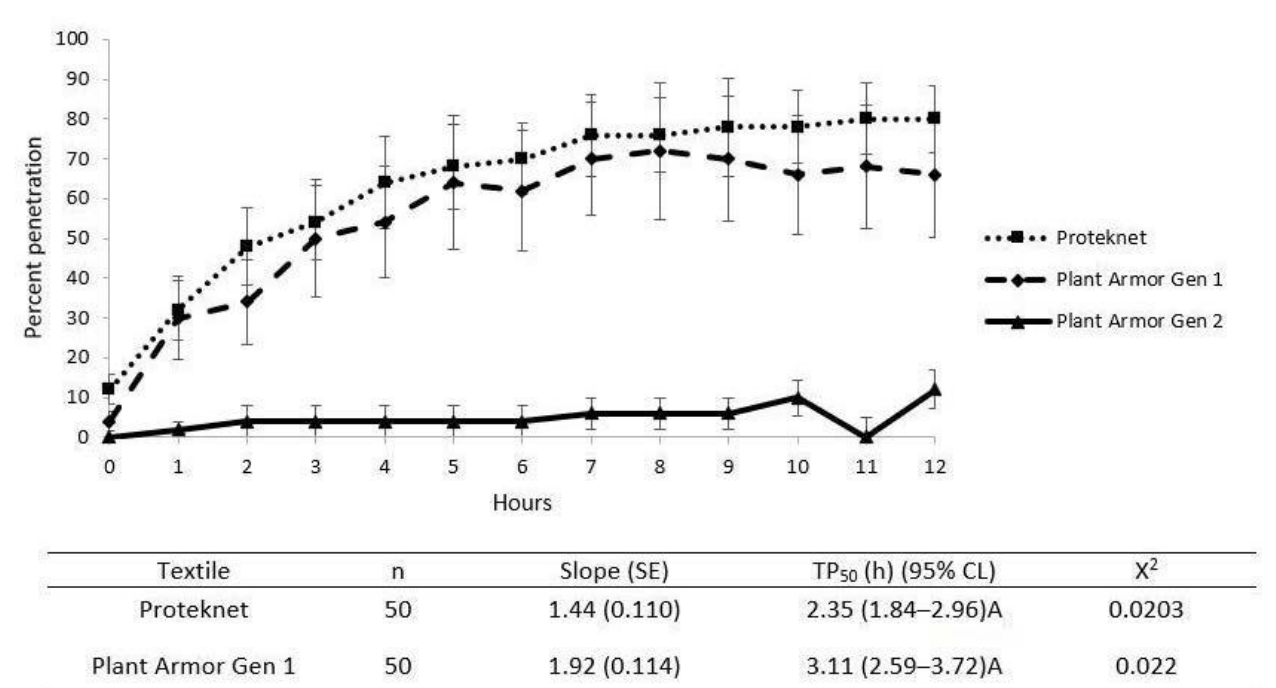
Figure 6. Penetration of neonate caterpillars of the bollworm, Helicoverpa zea , versus time in the Petri dish bioassay (Figure 1) for Proteknet and Plant Armor Generation (Gen) 1 and 2 textiles. The error bars are ±1 SEM. The probit model data are shown beneath the graph. A probit model for Plant Armor Gen 2 could not be determined because penetration never exceeded 11%.